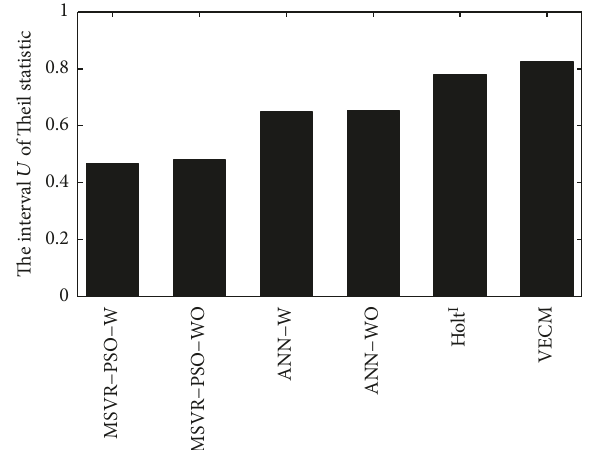
Figure 10: Prediction performance of examined methods in terms of 𝑈 I